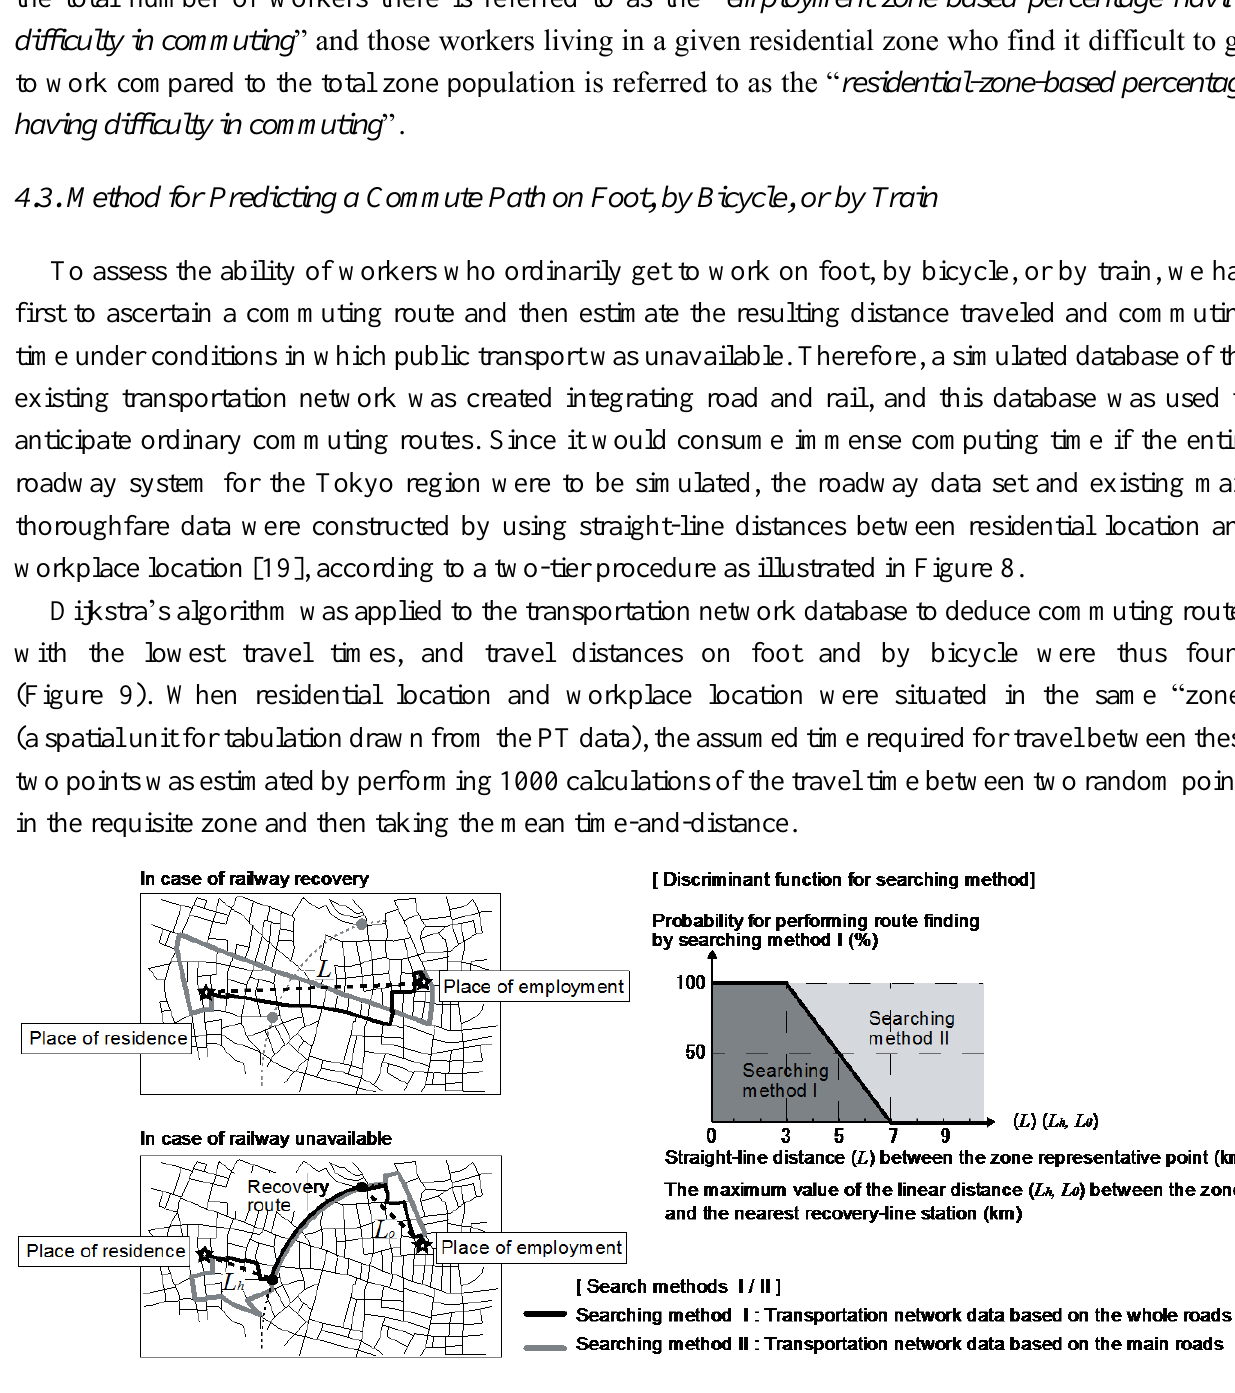
Figure 8. Method for discriminant selection of search methods I and